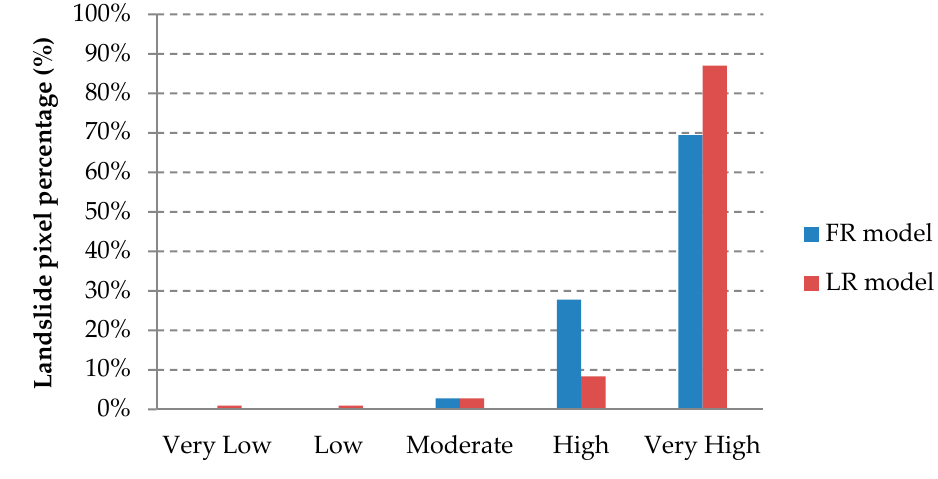
Figure 6. Landslide pixel percentages of landslide susceptibility categories.